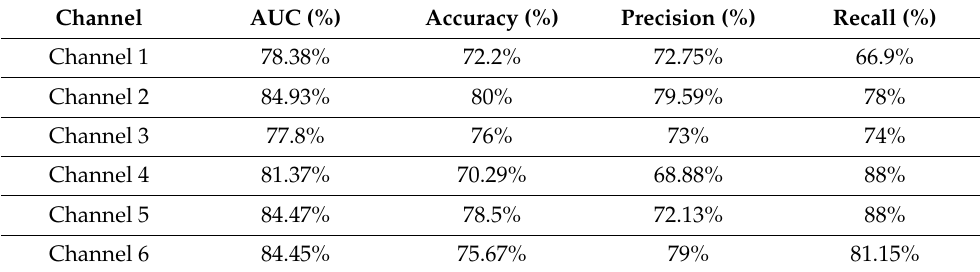
Table 6. Accuracy, area under curve (AUC), precision and recall results for model 2, 30 s epochs.